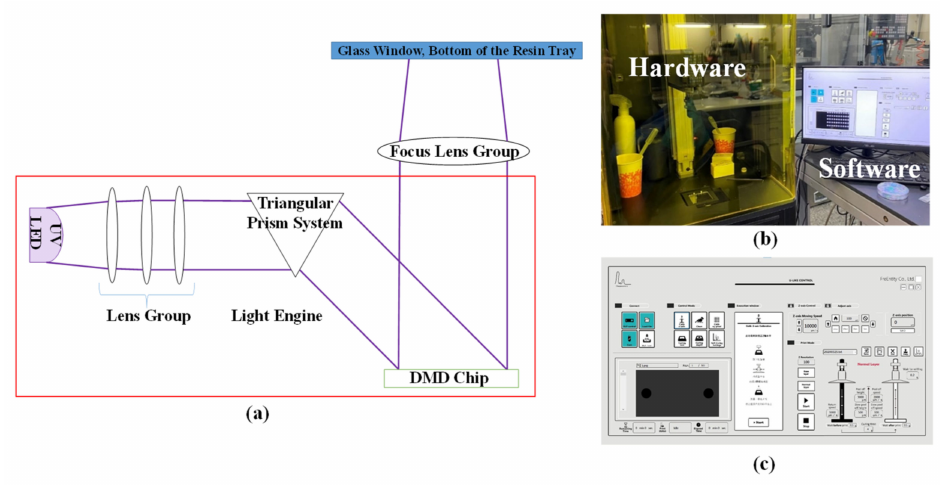
Figure 1. ( a ) Schematic illustration showing the proposed SL additive manufacturing system; ( b ) SL system including hardware and software; ( c ) software control